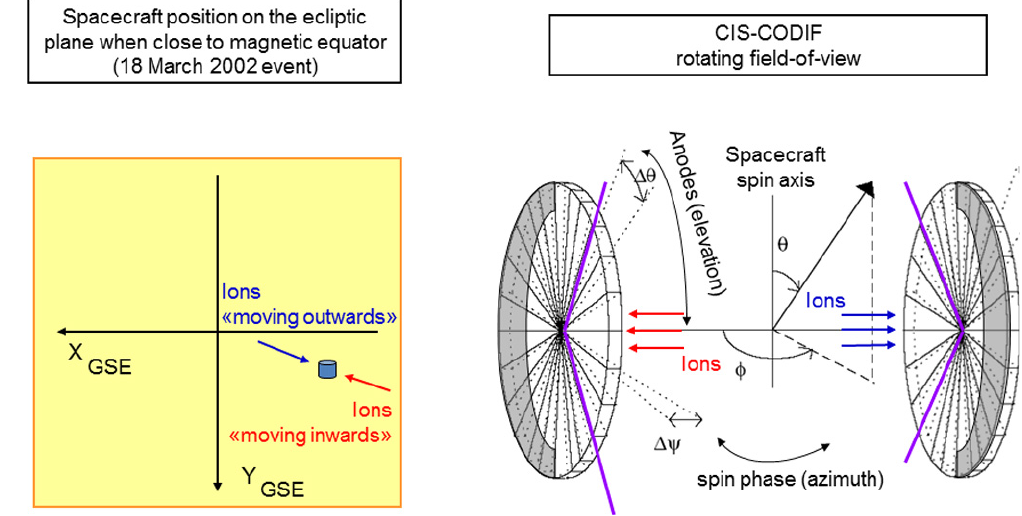
Fig. 4. Principle for the acquisition of two partial distribution functions: one corresponding to ions flowing radially outwards (blue arrows) and one to ions flowing radially inwards (red arrows). The left panel shows schematically the position of the spacecraft on the ecliptic plane, when it was close to the magnetic equator. The right panel shows the CIS-CODIF rotating field of view, first during the portion of the spacecraft spin phase when it was detecting ions flowing radially inwards (red arrows), and then, half a spin period later, when the same anodes were detecting ions flowing radially outwards (blue arrows). The thick magenta lines delimit the instrument field of view in ± 45 ◦ in elevation (anodes selected for this study). The grey-shaded part of the detector is not used in this